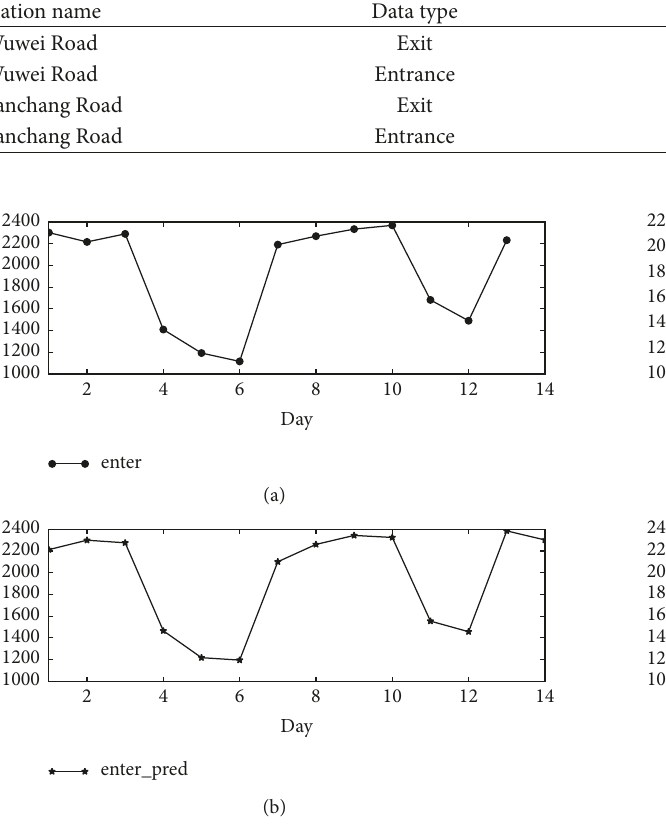
Figure 11: Prediction of daily entrance passenger flow of Wuwei rail transit station (multiple linear regression).